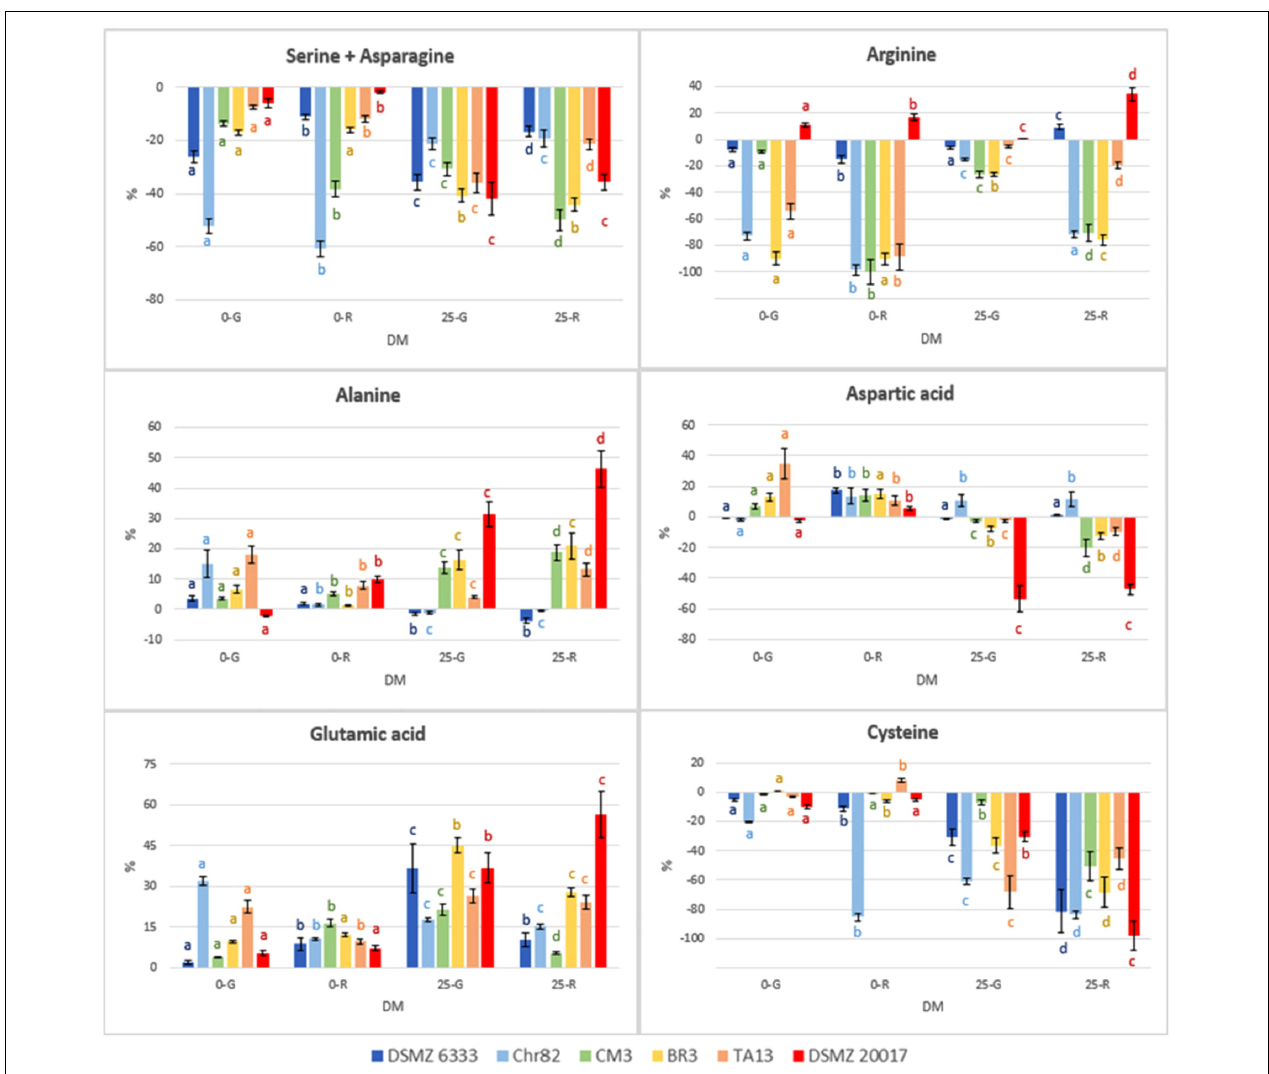
FIGURE 5 | Percentage variation with respect to the initial concentration in the DM of amino acids characterized by the most relevant modification after 24 h of incubation. The standard deviations are reported. For each strain, different letters indicate significant differences in the amino acid variation with respect to